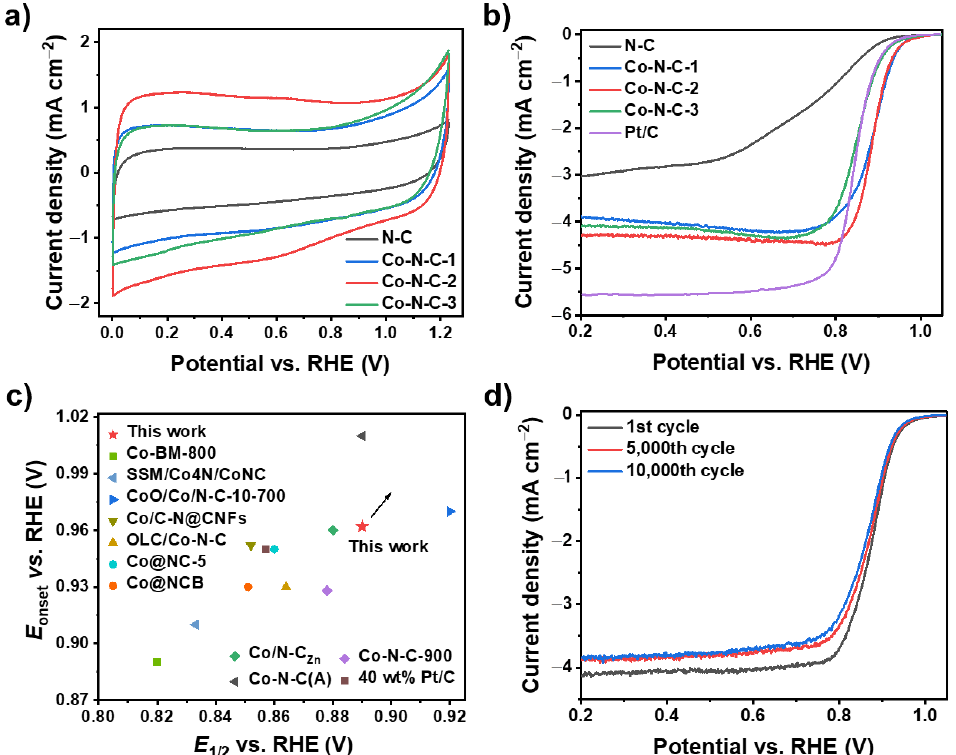
Figure 5. ( a ) CV curves of the catalysts in N 2 -saturated 0.10 M KOH; ( b ) ORR polarization curves of the catalysts in O 2 -saturated 0.10 M KOH; ( c ) comparison of the E onset and E 1/2 of the Co-N-C-2 to- wards ORR with the previously reported catalysts [35,38,40–47]; ( d ) ORR polarization curves of Co- N-C-2 catalyst after different potential cycles in O 2 -saturated 0.10 M